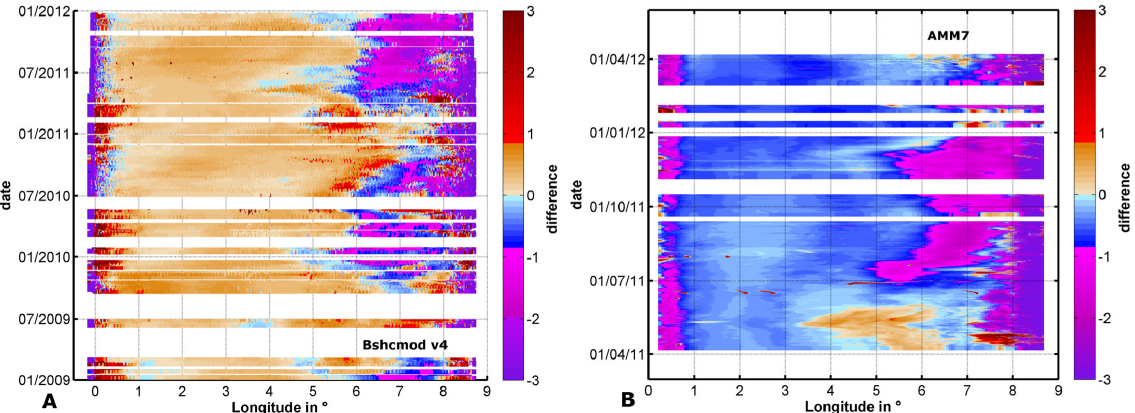
Figure 7. Differences in salinity for the TorDania transect (left side BSH–TorDania, right side AMM7–TorDania). The eastern England coast is located on the left side, the German Bight on the right side. Positive values indicate model overestimation. Differences are statistically significant beyond ± 0.8 (2-fold SD of FerryBox, in red and purple colours).